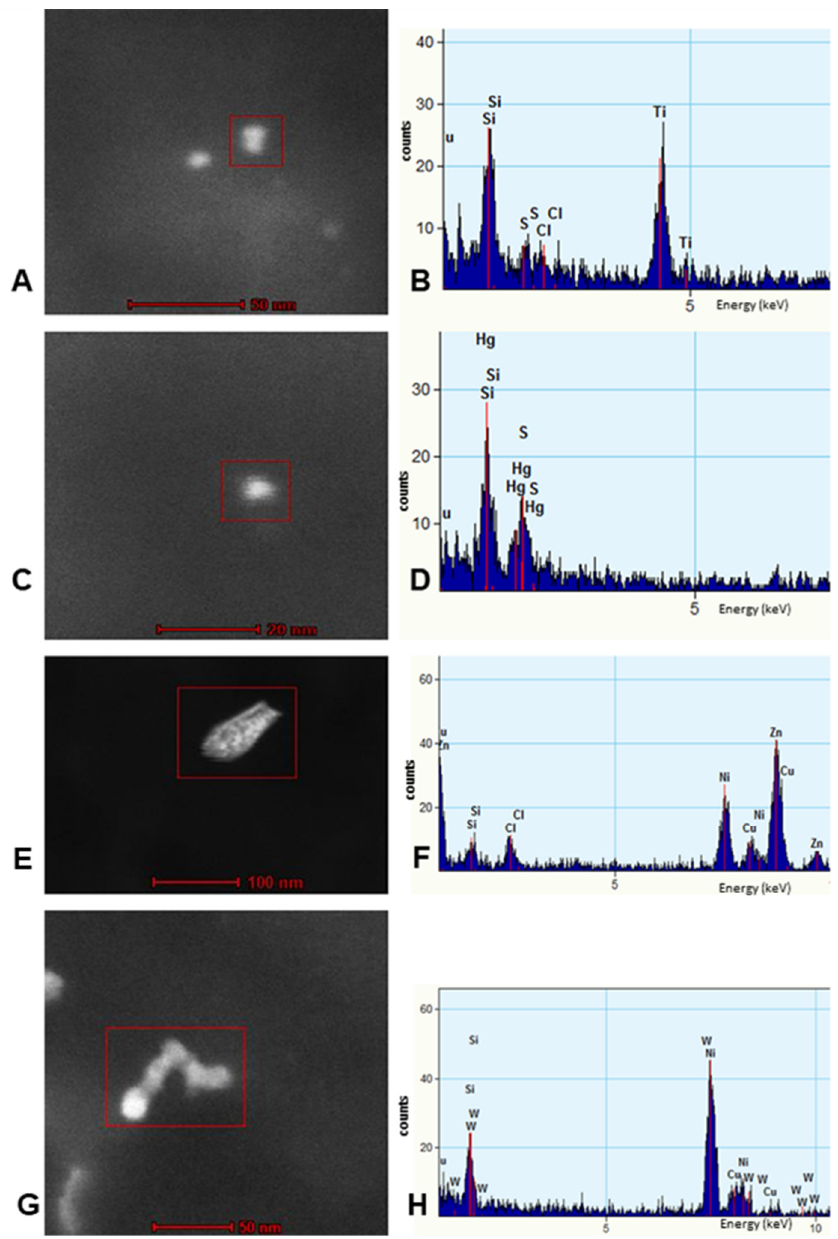
Figure 8. Locus coeruleus NP characterization by TEM and EDX. TiNPs were commonly identified throughout LC noradrenergic neurons ( A , B ). HgNPs were very common ( C , D ), while other metals such as W and Zn were also present ( E – H ). The Tungsten W NP in this picture comes from a 15-year-old girl ( G ) and measures 18 ± 2 nm wide and 77 ± 2 nm in length. Red squares included the NPs examined.